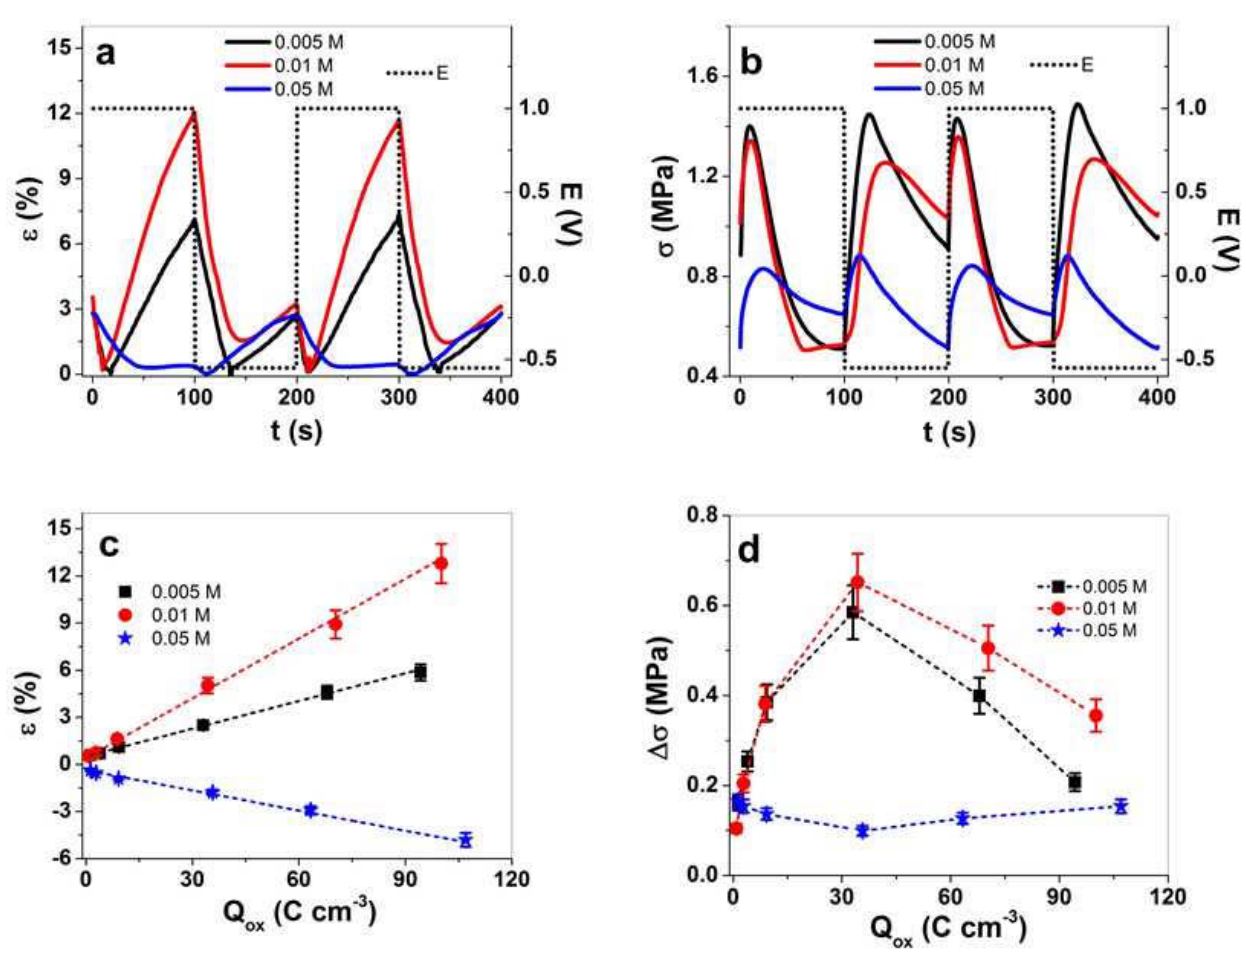
Figure 5. Square potential steps of PPy/DBS-PT films in the TBAPF 6 -PC electrolyte with different PTA concentrations during polymerization, such as 0.005 M (black line, ∎ ), 0.01 M (red line, ● ), and 0.05 M (blue line, ⋆ ), at a frequency of 0.005 Hz in ( a ) strain, ε , and in ( b ) stress, σ , against time, t, at potential range, E (dotted line, 1.0 to − 0.55 V) of two subsequent cycles (3rd and 4th). The strain, ε , is shown in ( c ) and the stress differences, ∆ σ , in ( d ) against the charge density upon oxidation, Q ox . Negative strain as shown in ( c ) refers to the main expansion upon reduction and positive strain to expansion upon oxidation. The dashed lines in ( c ) represent the linear fit and are shown for orientation only.